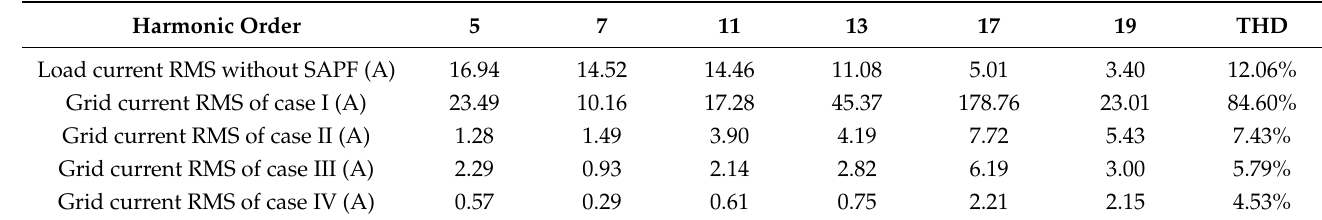
Table 2. Harmonic analysis results in different case simulations.